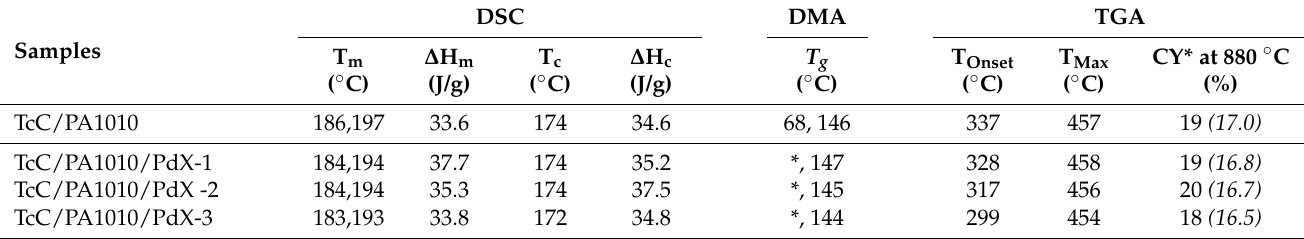
Table 3. Thermophysical transitions from the DSC and DMA, and thermochemical transitions from the TGA responses of TcC/PA1010 with and without